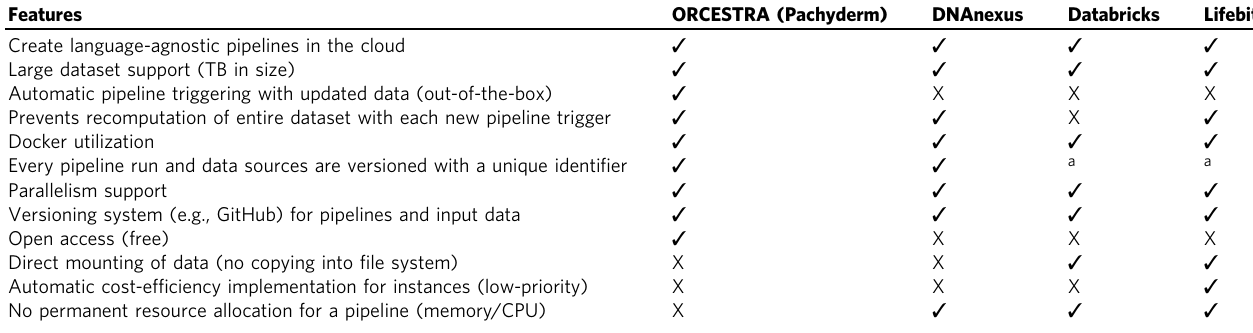
Table 1 Data-processing platforms and their respective features for handling multimodal data.